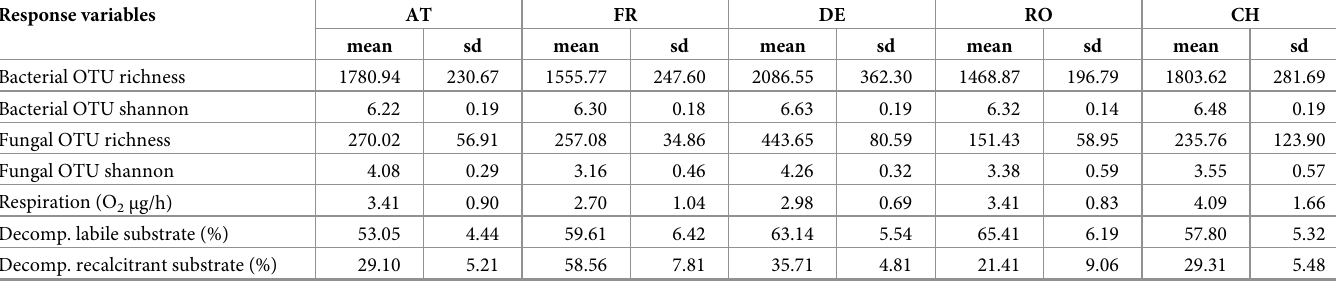
Table 1. Mean values and standard deviation (sd) of microbial alpha diversity parameters and soil functions for each country (AT, Austria; CH, Switzerland; DE, Germany; FR, France; RO, Romania). Bacterial and fungal richness are represented by the number of OTUs, bacterial and fungal OTU Shannon diversity (shannon), microbial respiration as measured by the consumption of O2 ( μ g/h), decomposition rates of labile and recalcitrant organic substrate is represented as weight loss of tea bags in